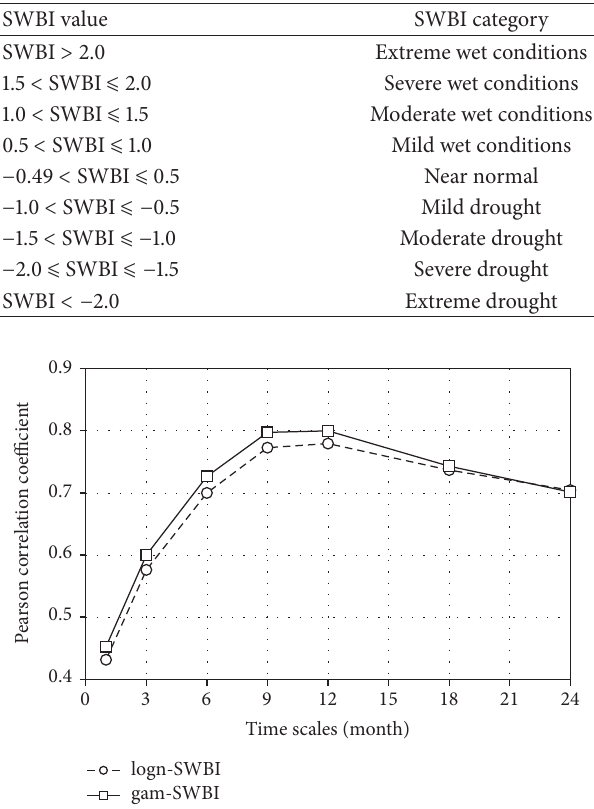
Table 1: SWBI classification.